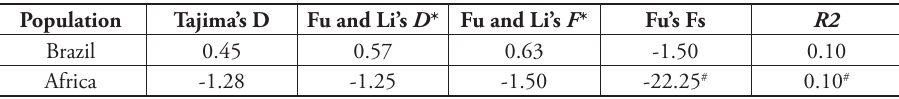
Figure 2. Haplotype network and relationships among 35 haplotypes of the domain I CR mtDNA re- gion found in cattle egret ( Bubulcus ibis ) samples from Brazil and Africa. Areas of shapes are proportional to number of individuals sharing each Table 2. Results of neutrality tests performed for Brazilian and African populations of cattle egret ( Bubulcus ibis ).